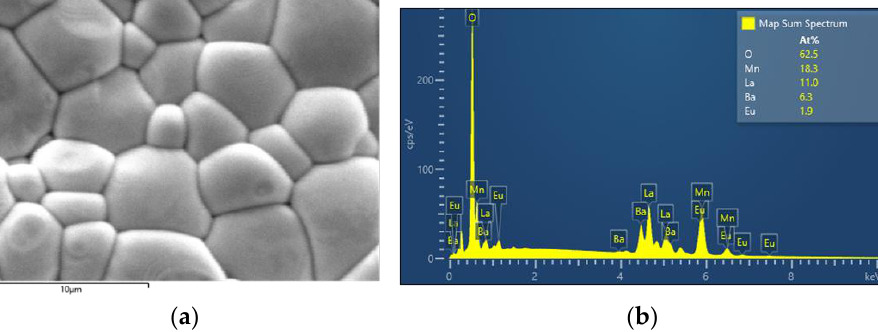
Figure 4. ( a ) SEM picture of the La 0.65 Eu 0.05 Ba 0.3 MnO 3 sample. ( b ) EDX for the La 0.65 Eu 0.05 Ba 0.3 MnO 3 sample.